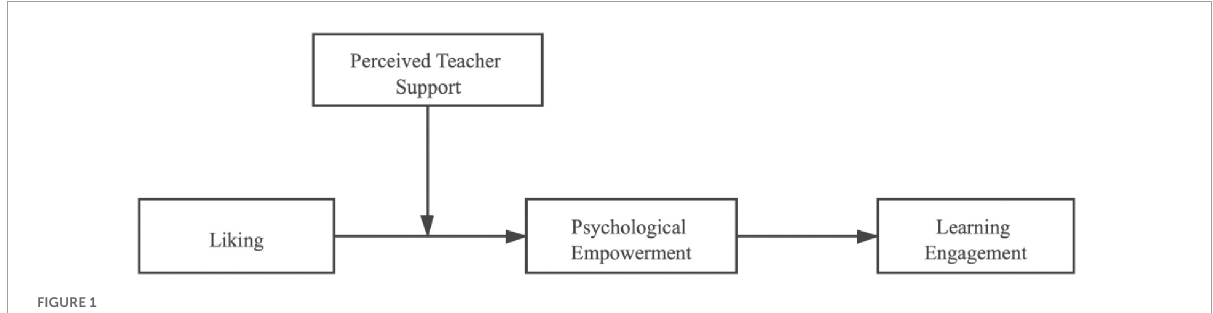
FIGURE1 Research model